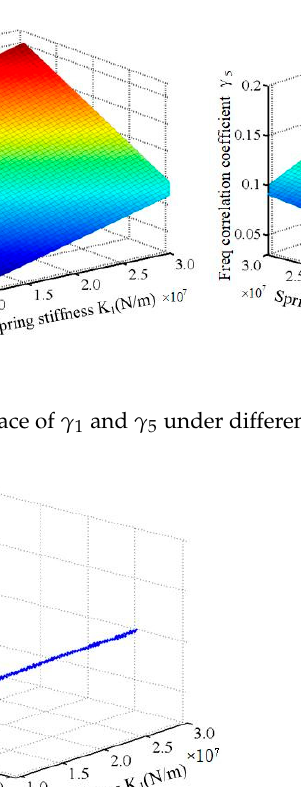
Figure 10. Composite curve of γ 1 and γ 5.